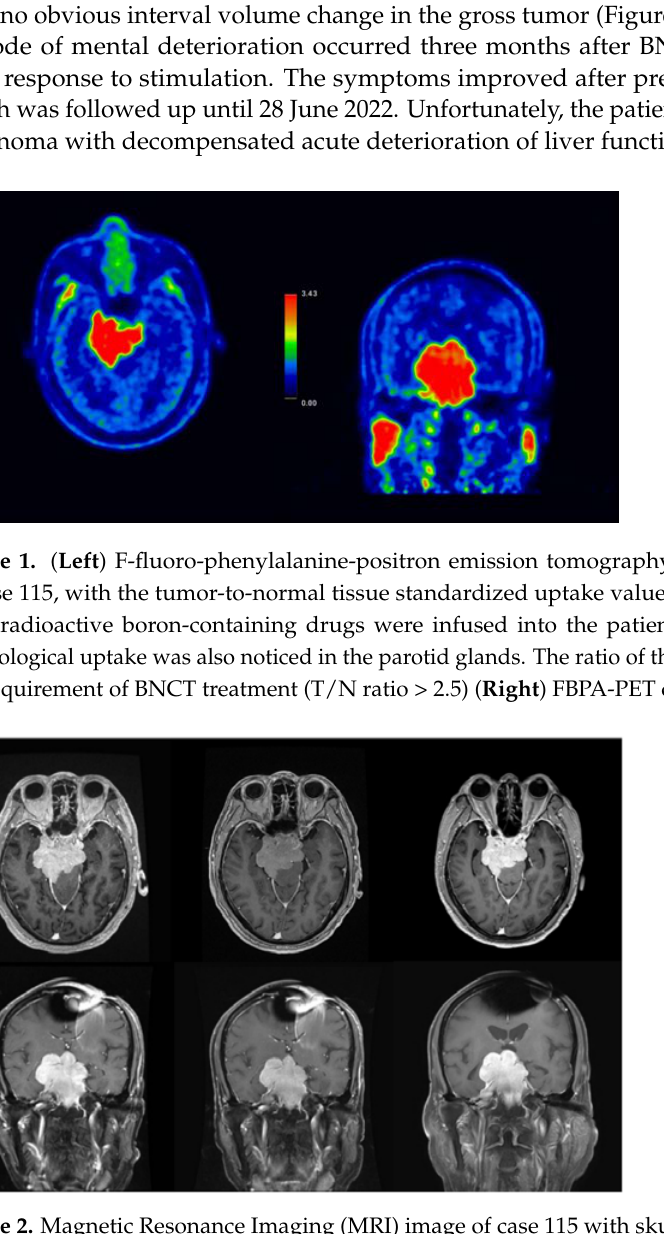
Figure 2. Magnetic Resonance Imaging (MRI) image of case 115 with skull base meningioma. ( Left upper ) Pre-BNCT, axial MRI with contrast. ( Left lower ) Pre-BNCT, coronal MRI with contrast. ( Middle upper ) Three months after BNCT, axial MRI with contrast. ( Middle lower ) Three months after BNCT, coronal MRI with contrast. ( Right upper ) 17 months after BNCT, axial MRI with contrast ( Right lower ) 17 months after BNCT, coronal MRI with contrast.